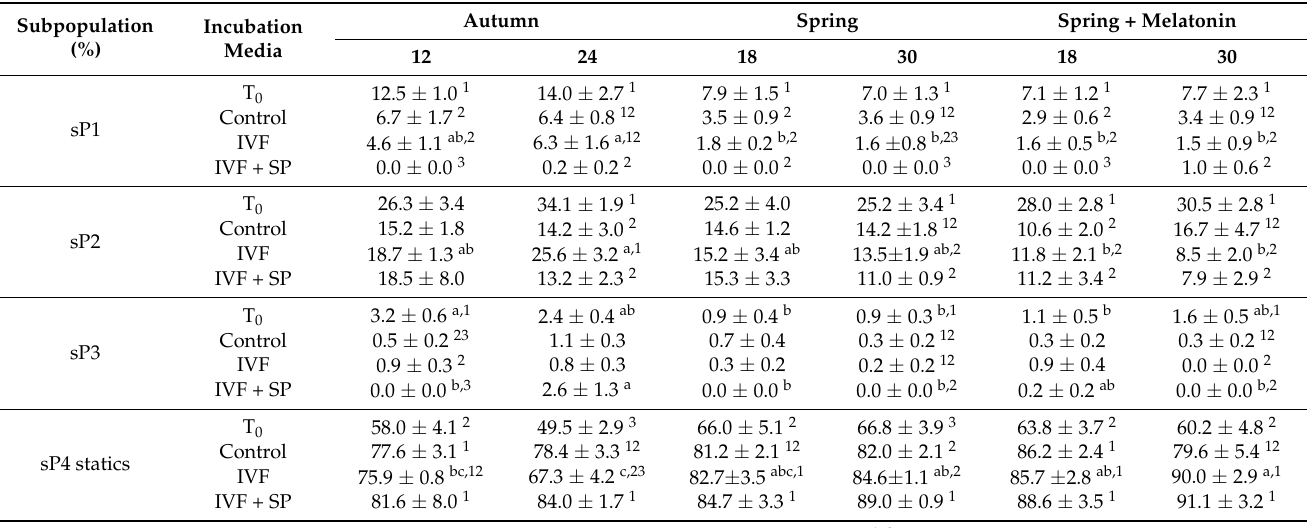
Table 5. Effect of seminal plasma and its resilience under in vitro capacitation conditions on thawed buck sperm motile subpopulation with respect to age (months), season, and melatonin